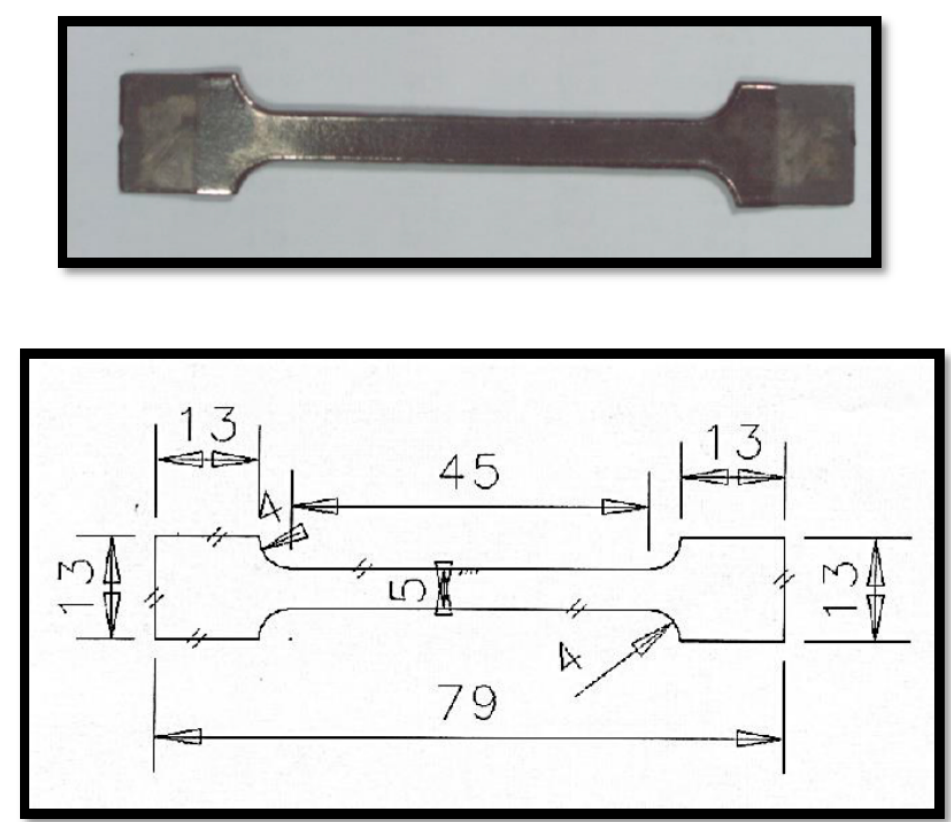
Figure 1. Tensile test specimen (all dimensions in mm).